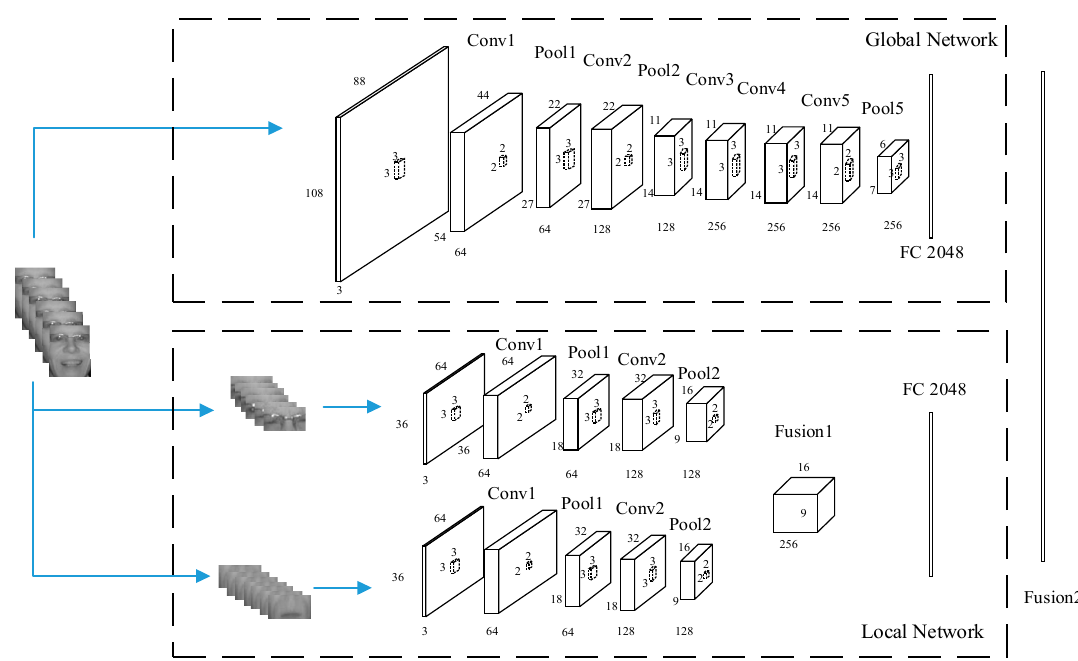
Figure 1. The proposed NIRExpNet for near-infrared facial expression recognition (NIR FER). Global network: the preprocessed whole face acts as input flow of network. The network employed medium-size VGG-M-2048 models. Local network: the two streams using same network that has two convolutional layers and two pool layers and are fused by Fusion 1. The global and local network are fused in Fusion 2.